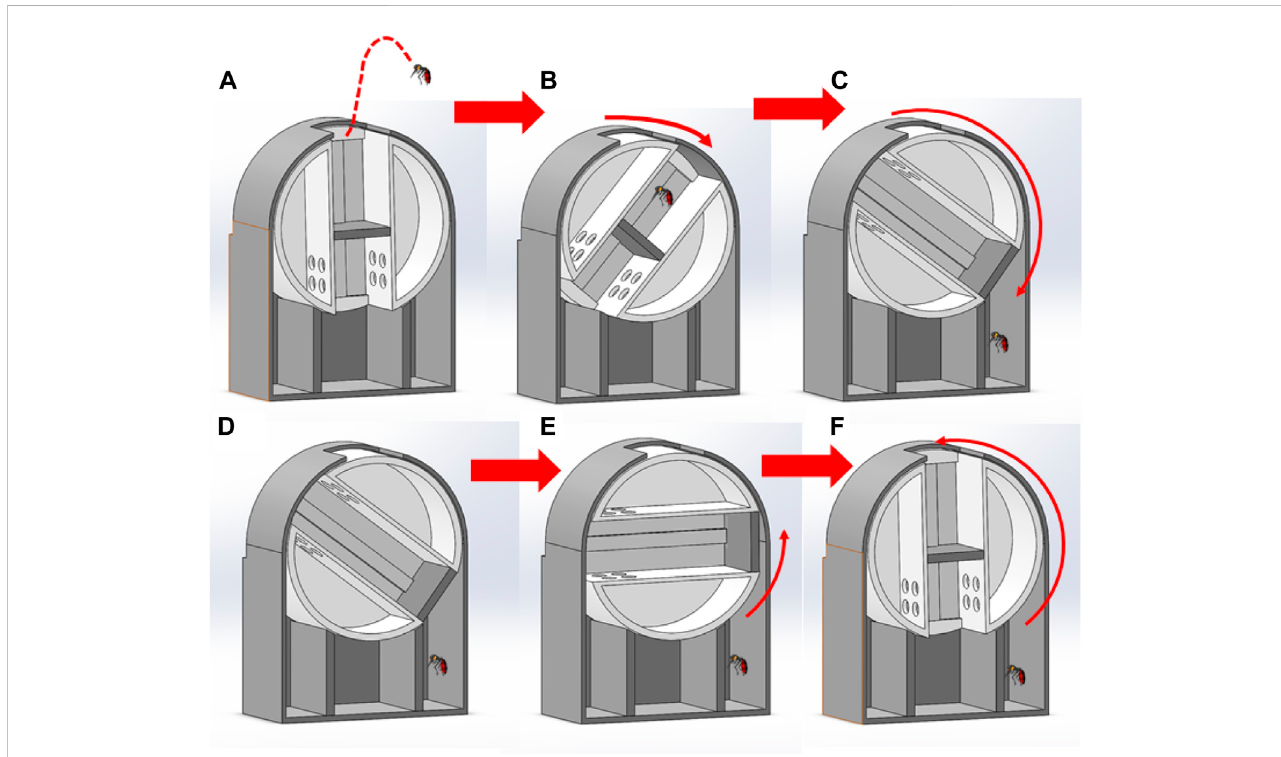
FIGURE 2 The mosquito trap uses a rotation method to capture and classify mosquitoes. (A) Mosquitoes fl y into the capture area. (B) The mechanism rotates, blocking the opening. (C) After the mechanism rotates to a certain angle, the rotation stops, and the chassis pushes the mosquitoes into the corresponding chamber. (D) Theplateremainsinthesamepositionforaperiodoftime. (E) Theplatewillthenrotateintheoppositedirection. (F) Theplaterotatesandreturns to its original